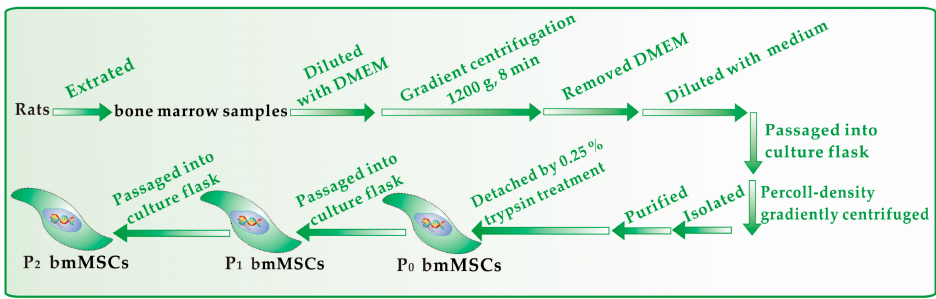
Figure 8. Experimental procedures for the preparation and culture of bmMSCs.